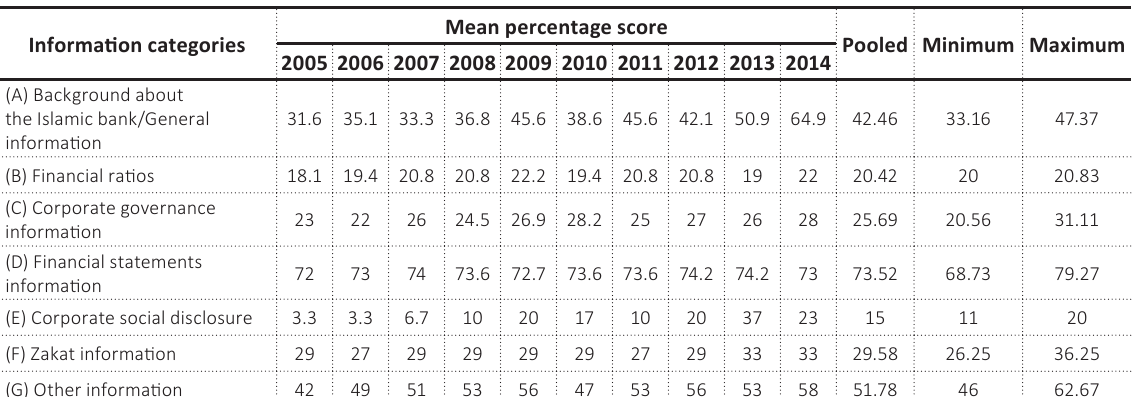
Table 6. Descriptive statistics for categories of the voluntary information disclosure index